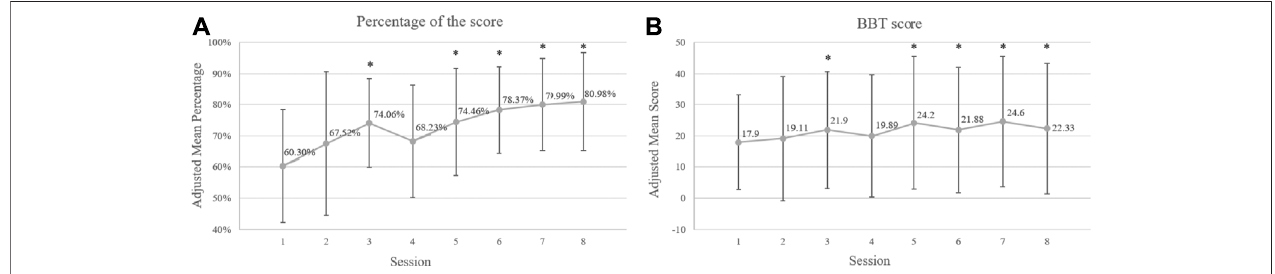
FIGURE 3 | (A) Eight weeks of performance scores of the Kinect game and (B) outcomes of the BBT among children with unilateral CP over training sessions. * statistical signi fi cance of p ≤ 0.05 compared to the